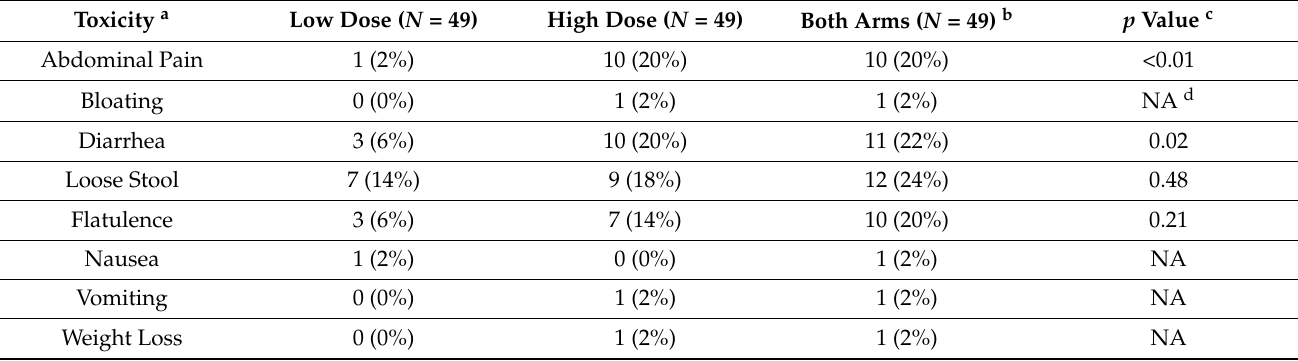
Table 3. Treatment-emergent adverse